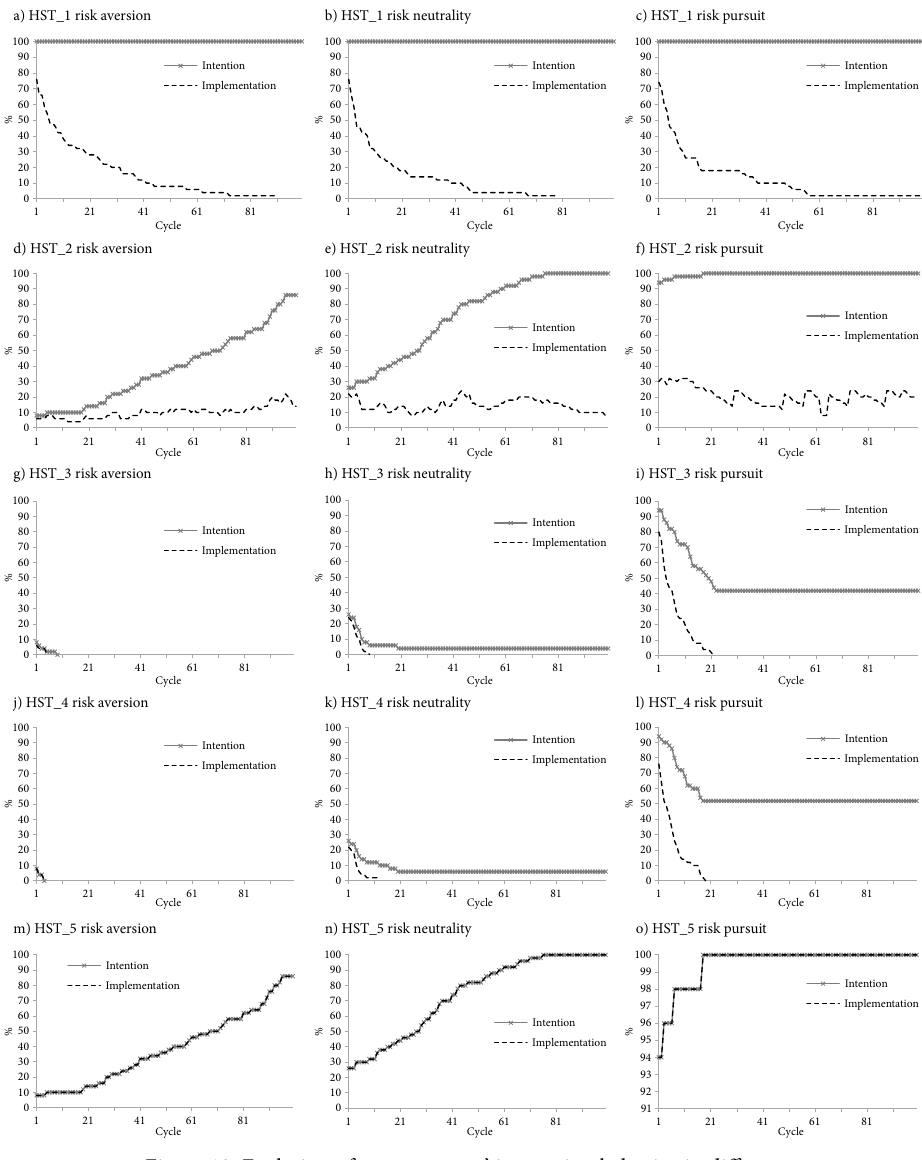
Figure 10. Evolution of entrepreneurs’ innovation behavior in different policy scenarios of high-structured social